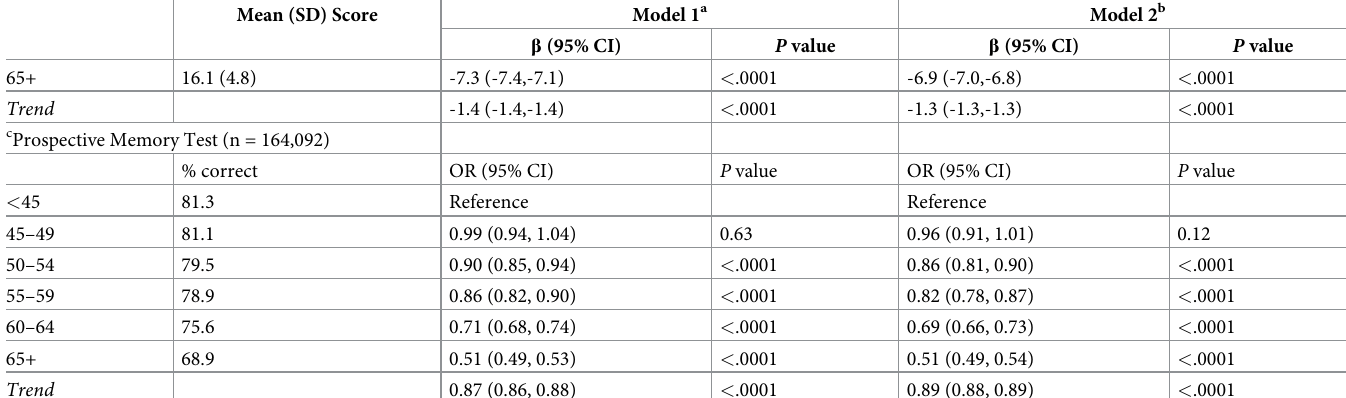
participants did not complete the first follow-up (~4 years) but returned for the second follow- up (~6 years). Because the mean scores were lower than baseline for these participants, practice effects were likely considerably weaker than that observed for the first follow-up. Table 3 and Fig 1 present results of the longitudinal analysis over an average follow-up time of 5.1 years. In multivariable analysis, FI decreased over follow-up among participants 65+ at baseline com- pared to those < 45 years at baseline (Model 1, P = 0.002), but was no longer statistically signifi- cant in multivariable analysis once accounting for multiple testing (Model 2, P = 0.02). No